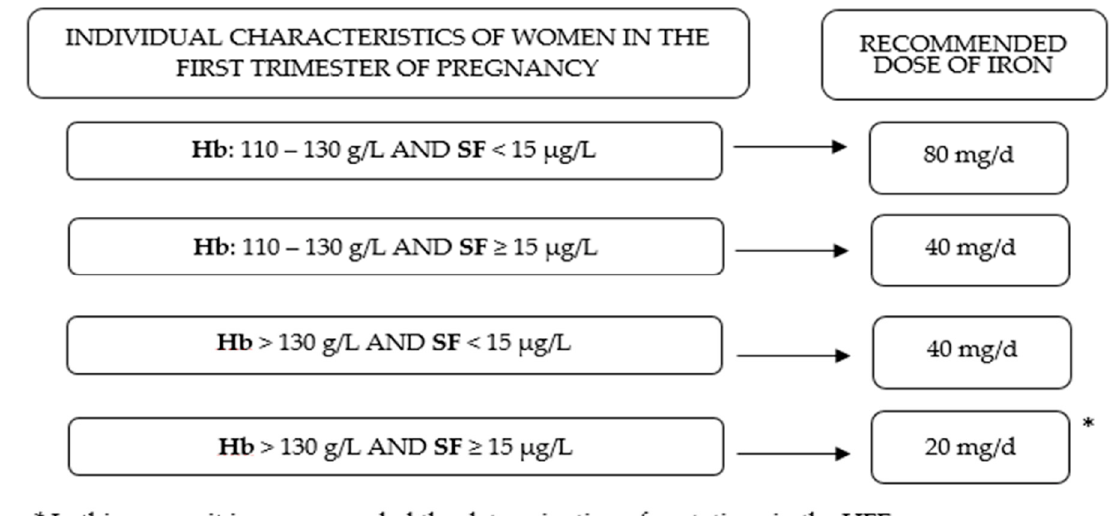
Figure 4. Adaptation of prenatal iron supplementation according the individual characteristics of women in the first trimester of pregnancy.